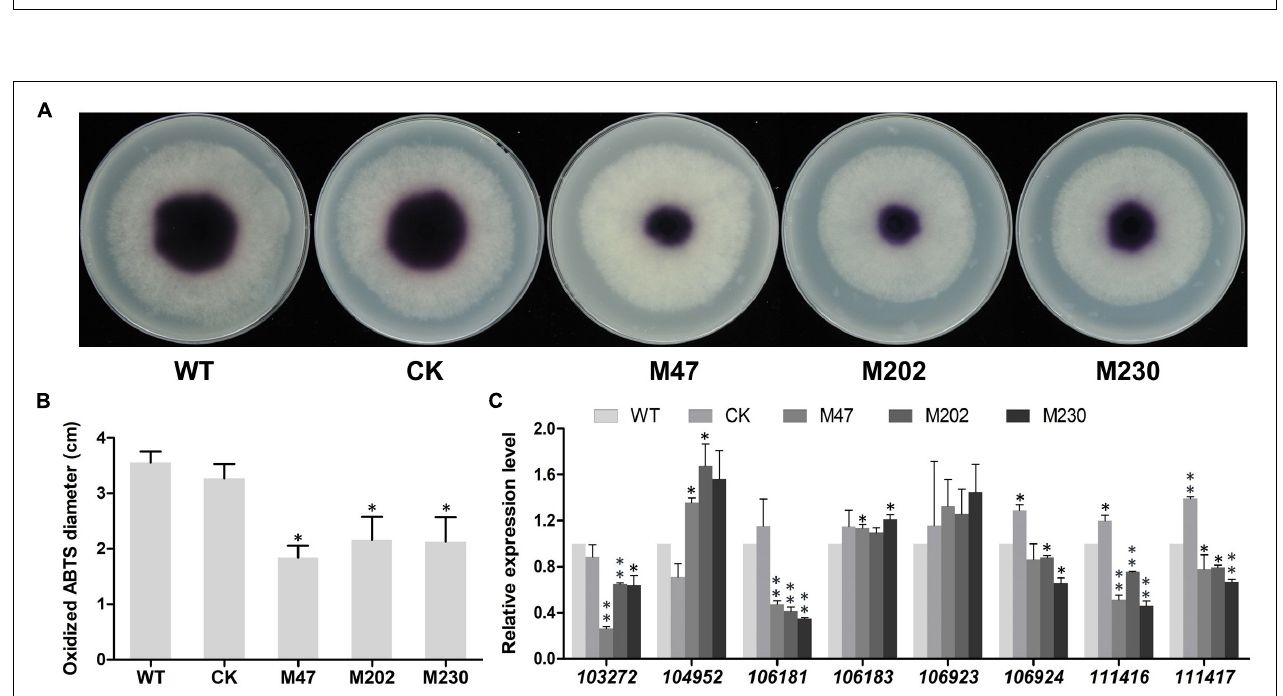
FIGURE 8 | Knockout of PlCB5L1 decreased the activity of extracellular laccase and transcription levels of laccase-encoding genes. (A) Laccase activity was determined by monitoring oxidized ABTS (purple color) in LBA media supplemented with 0.2 mM ABTS, photographs were taken 7 days after inoculation. (B) The diameters of oxidized ABTS (dark purple) were measured at 7 days post inoculation. (C) Relative expression of eight laccase-encoding genes in WT (set at 1), CK and (cid:49) plcb5l1 mutants under oxidative stress conditions, 5 mM H 2 O 2 for 5 min. Data are mean ± SD ( n = 9, ** p < 0.01, * p < 0.05; Student’s t -test).